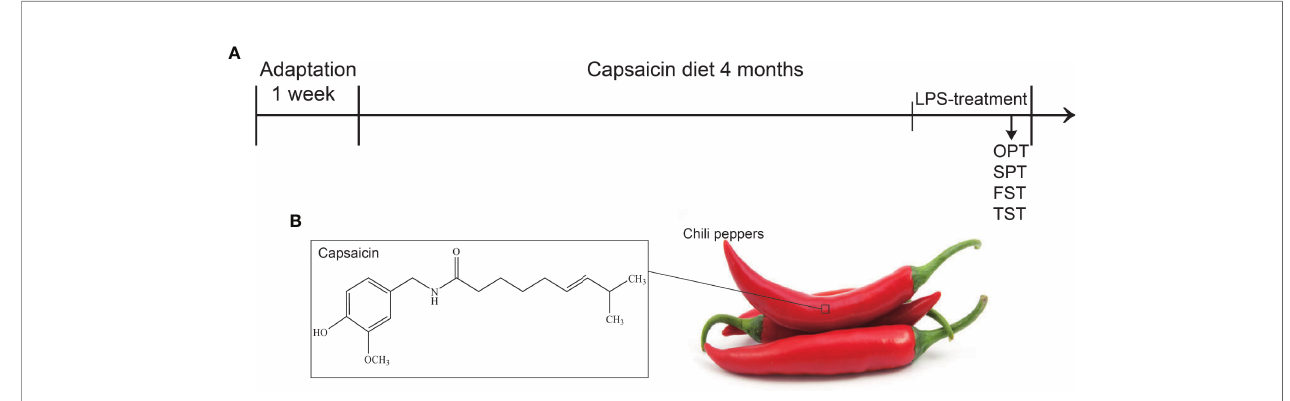
FIGURE 1 | (A) Schematic procedure of the experiments: SPT, sucrose preference test; FST, forced swimming test; TST, tail suspension test; (B) The chemical structure of CAP isolated from chili